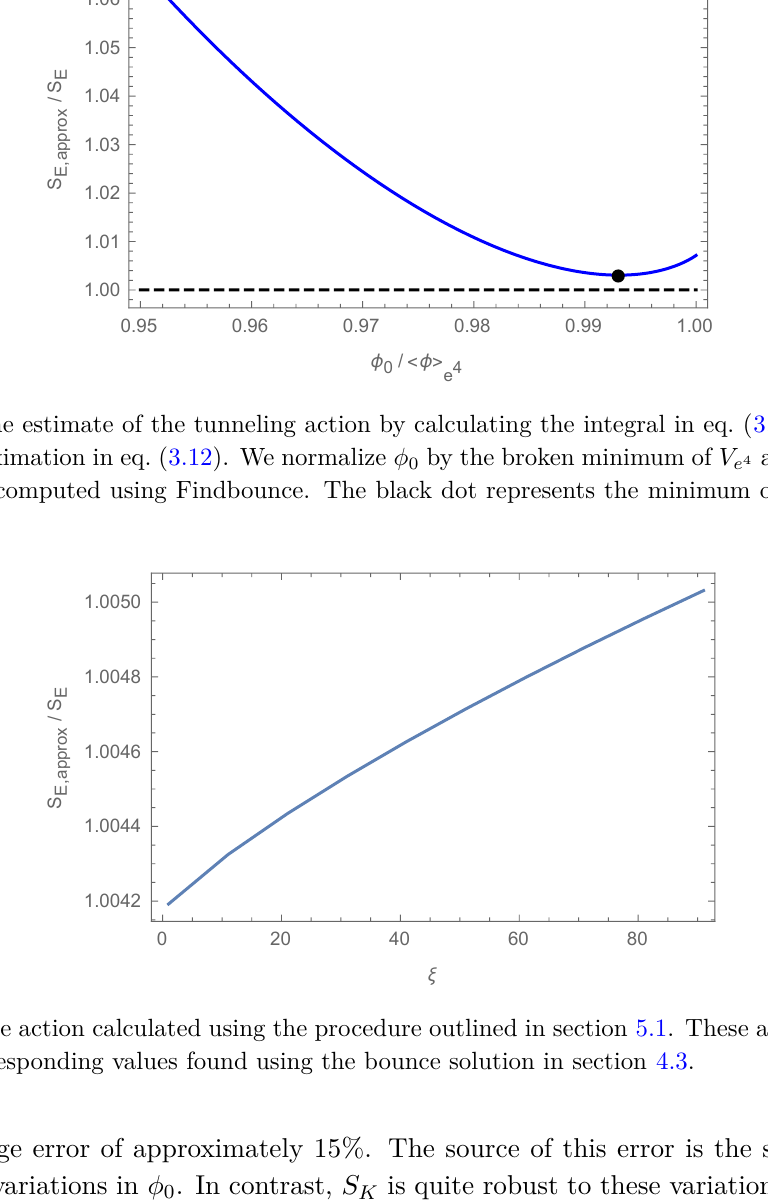
Figure 5. The action calculated using the procedure outlined in section 5.1. These are normalized using the corresponding values found using the bounce solution in section